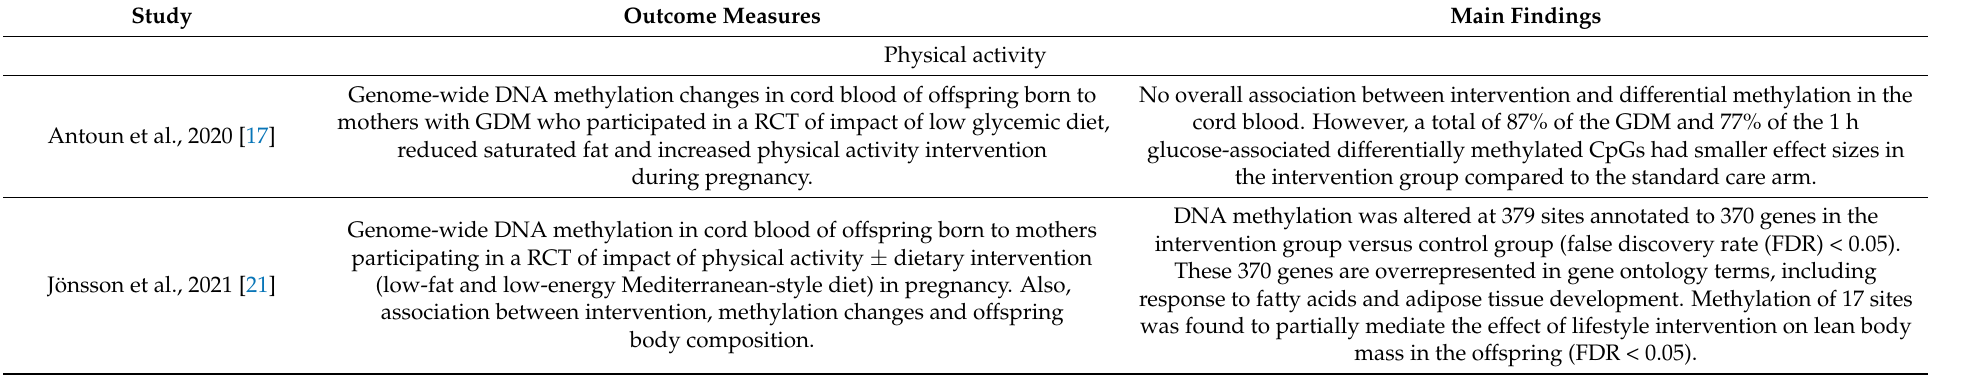
Table 2. Outcome measures and main findings according to